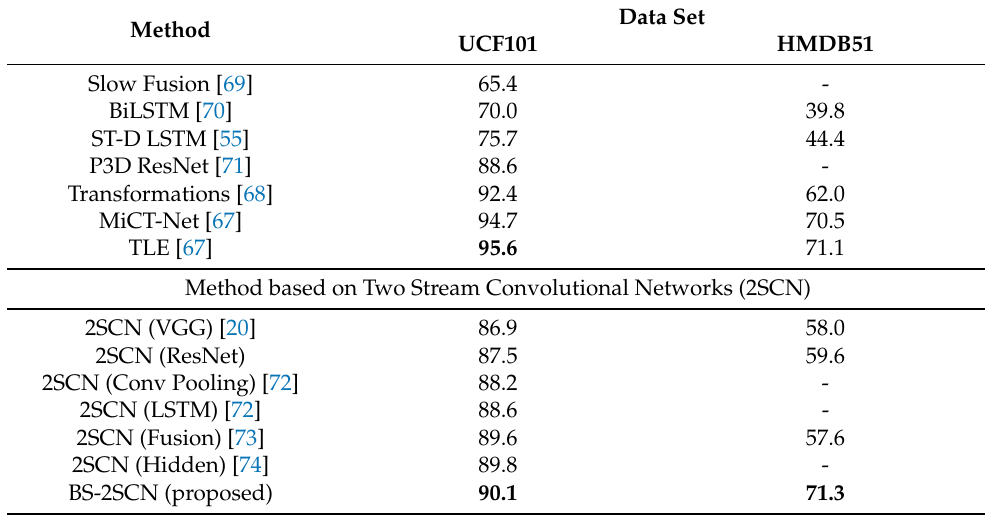
Table 1. Accuracy comparison of action recognition algorithms on UCF101 dataset and HMDB51 dataset